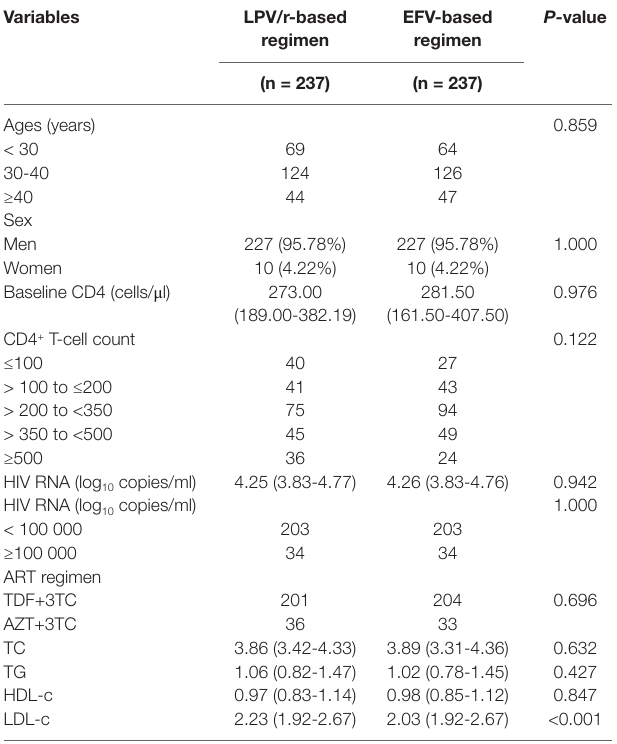
TABLE 1 | Baseline demographic and clinical characteristics.